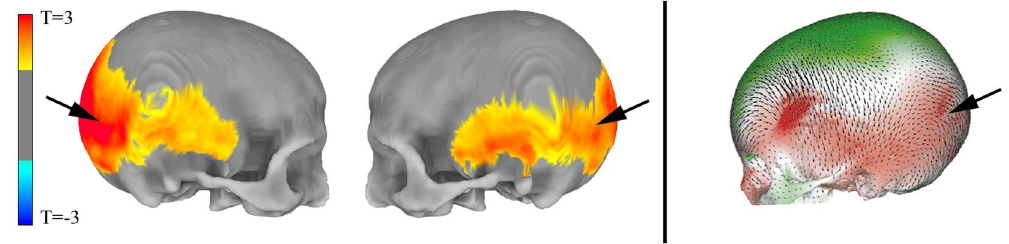
Figure 1. NeanderScore related skull shape changes. Associations between skull morphology and percentage of Neanderthal-derived SNPs (NeanderScore) in modern humans (Left), compared to differences between Neanderthal and modern human skulls (Right). Left panel shows regions with morphological changes, measured in vivo , related to NeanderScore and overlaid on the average skull of all 146 participants. Warm colors represent areas for which NeanderScore correlated with skull expansion (p < 0.05, FWE-corrected). There were no findings in the opposite direction. Right panel depicts previously published shape differences between Neanderthals and modern humans, from archeological samples, overlaid on a modern human skull. Red regions represent skull expansion in Neanderthals relative to modern humans; green represents contraction, adapted by permission from Macmillian Publishers Ltd: Nature 2, © 2001. Note the convergence of in vivo and archeological data in occipito-parieto-temporal regions (arrows).